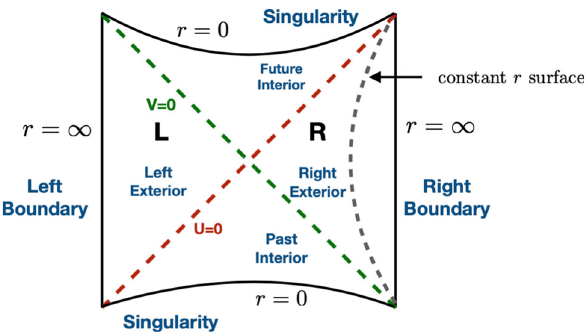
Fig. 2 Penrose diagram representing an eternal Schwarzschild-AdS black hole [58]. Also shown are the left and right boundaries where the CFT lies and which the system is dual to. The diagonal lines represent the left and right black hole’s horizons. r = 0 corresponds to the sin- gularity of the spacetime. The original exterior region is the right one ( R ) and the new exterior is the left one ( L ). No radial null geodesic can escape the future interior into one of the exterior and no null geodesic can connect the left and right